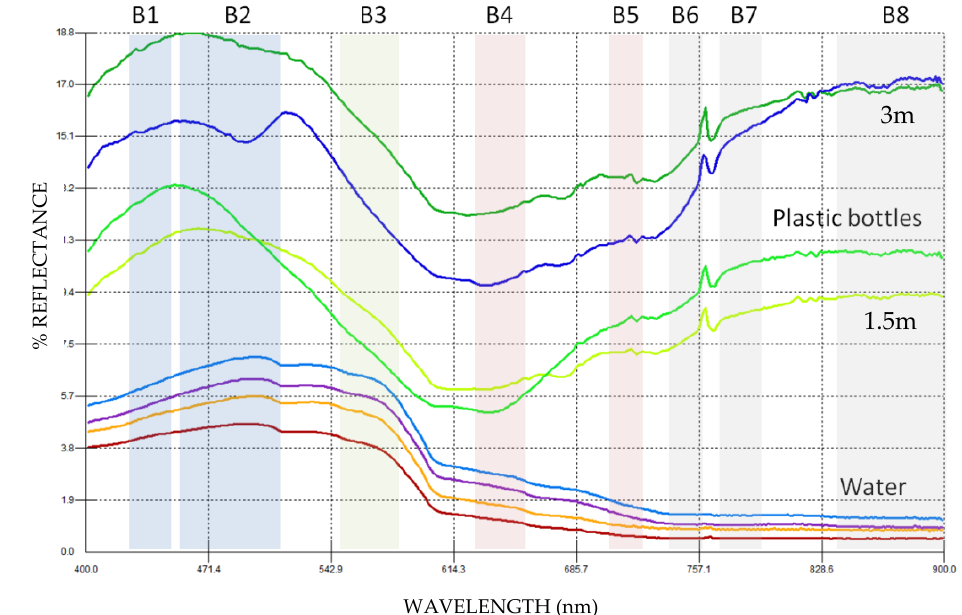
Figure 7. Average spectral signatures plotted against the different channels of the Sentinel-2 satellite. The red, orange, purple and cyan lines indicate the spectral signatures for water, while the light green, green, blue and dark green lines indicate the spectral signatures for the plastic bottles in the water at different heights (1.5 m and 3 m).